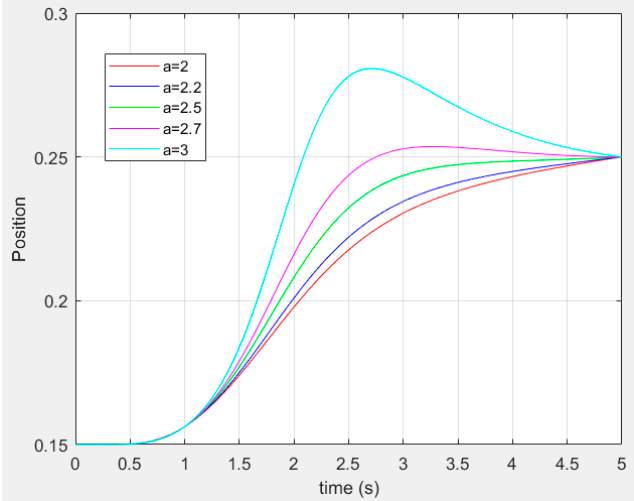
Figure 5. Different examples of trajectories for different values of 𝑎 and a total time equal to 5.